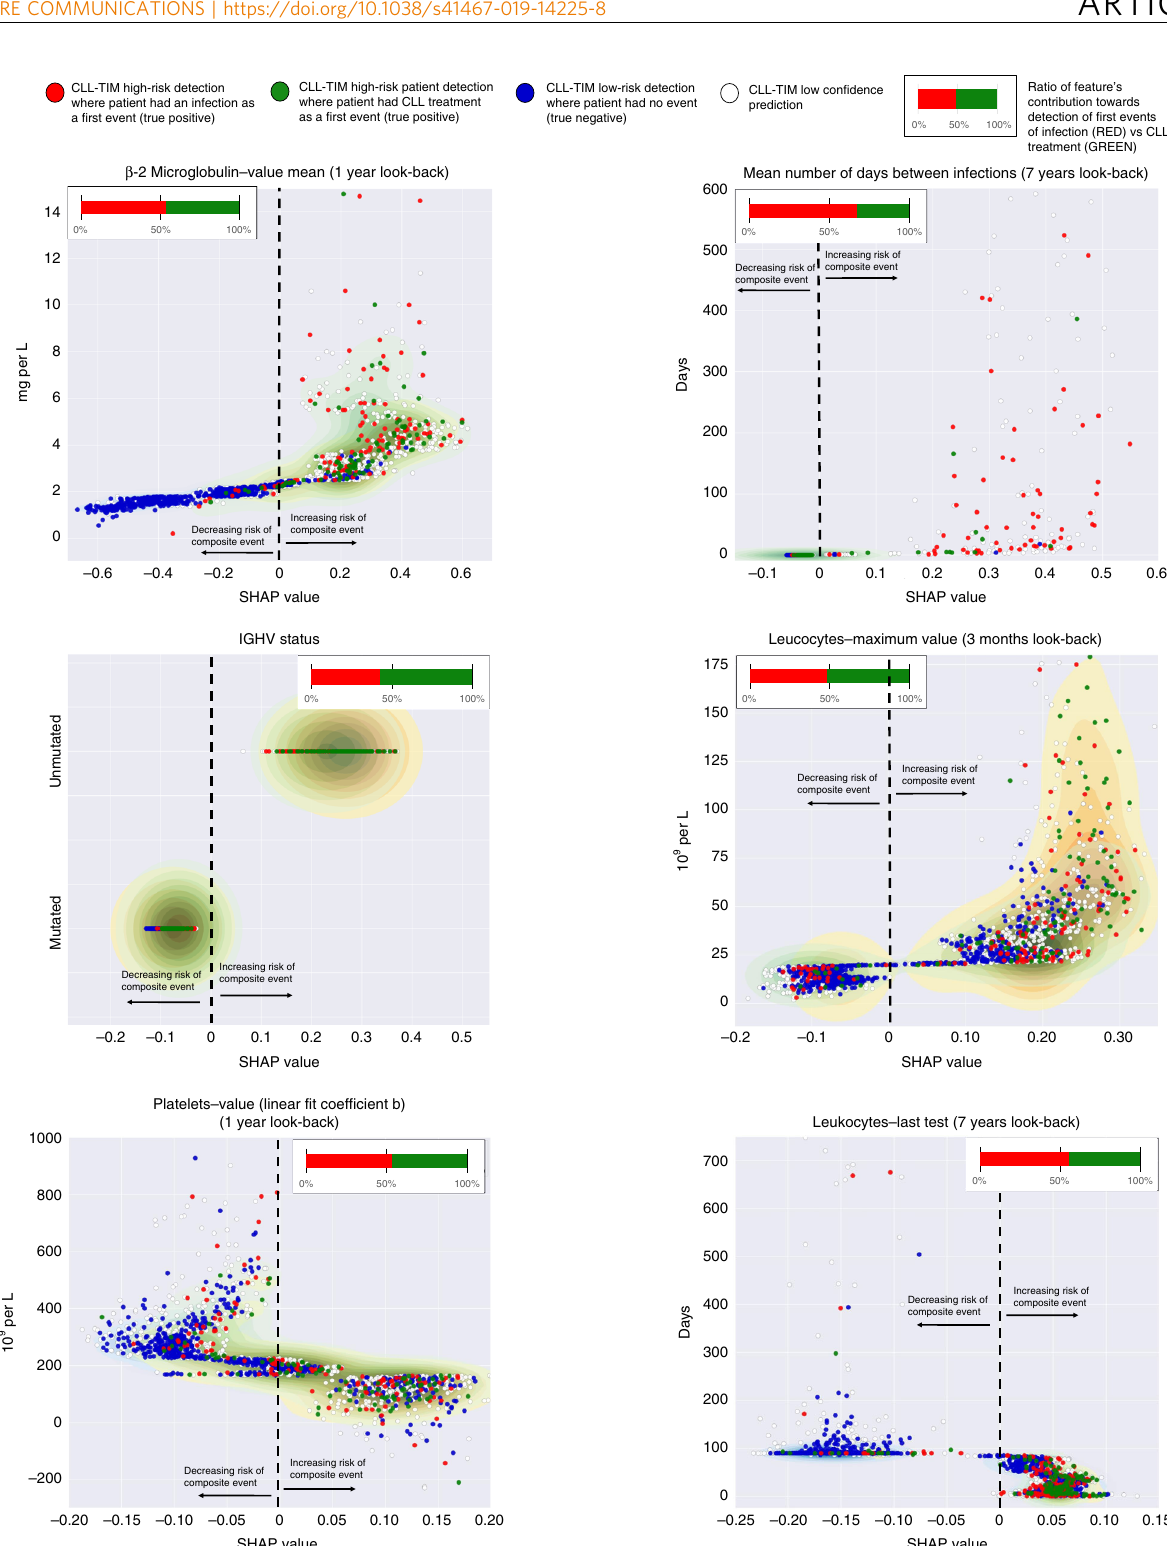
Fig. 8 Non-linear relationships between risk factors and the composite outcome. Variable-to-risk mappings learned by CLL-TIM are presented for a selection of key risk-factors. Red and green circles are for high-con fi dence true-positive predictions were patients had an infection and CLL Treatment as a fi rst event respectively. Dark blue circles are for high-con fi dence true-negative predictions. Low-con fi dence predictions are shown in white circles. On the y-axis the real feature value for the given patient is shown and, on the x -axis, the respective SHAP feature value for the given patient is shown. Plots were generated using 3720 Danish CLL patients (i.e. training, validation and test